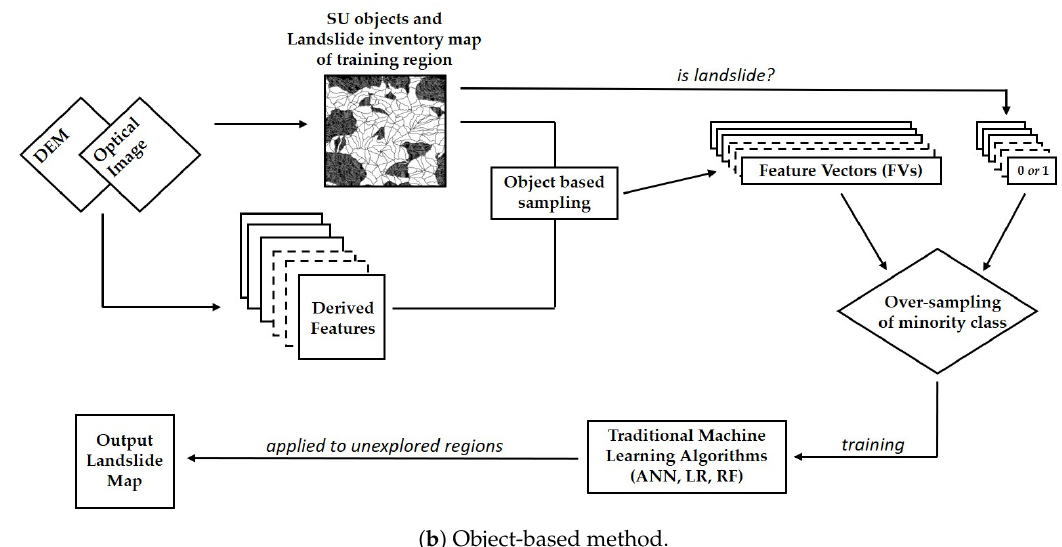
Figure 1. Simplified training architecture for mapping landslides using machine